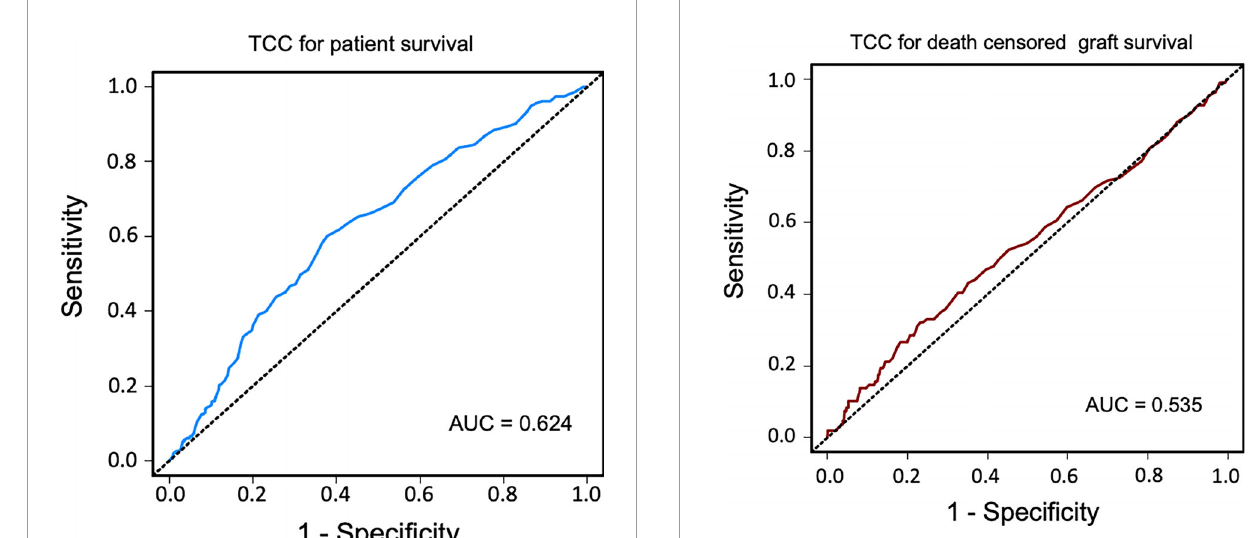
FIGURE 6 | Receiver operating characteristic (ROC) curve analysis of plasma terminal C5b-9 complement complex (TCC) concentration, 10 weeks after transplantation, as a biomarker of overall patient survival. A cutoff value of <0.7 CAU/ml resulted in a speci fi city of 0.87 and sensitivity of 0.22.